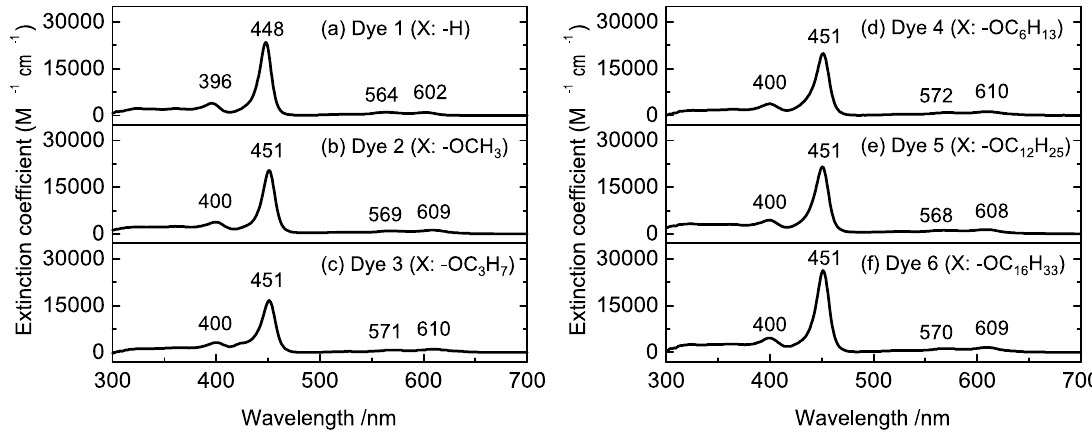
Figure 3. UV ‐ vis spectra of Dyes 1 – 6 in CH 2 Cl 2 .